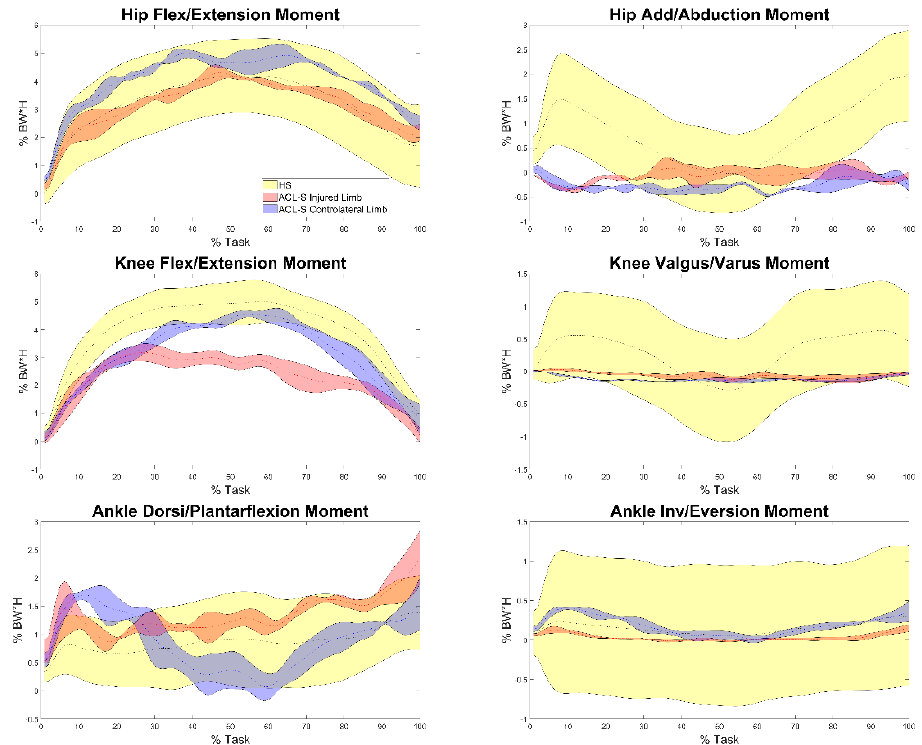
Figure A1. Hip, knee and ankle adduction/abduction and flexion/extension moments, calculated through inverse dynamics: HS (yellow), ACL-S injured limb (red) and ACL-S contralateral limb (blue). Average plus and minus one standard deviation are reported as coloured bands. Average plus and minus one standard deviation are reported as coloured bands.